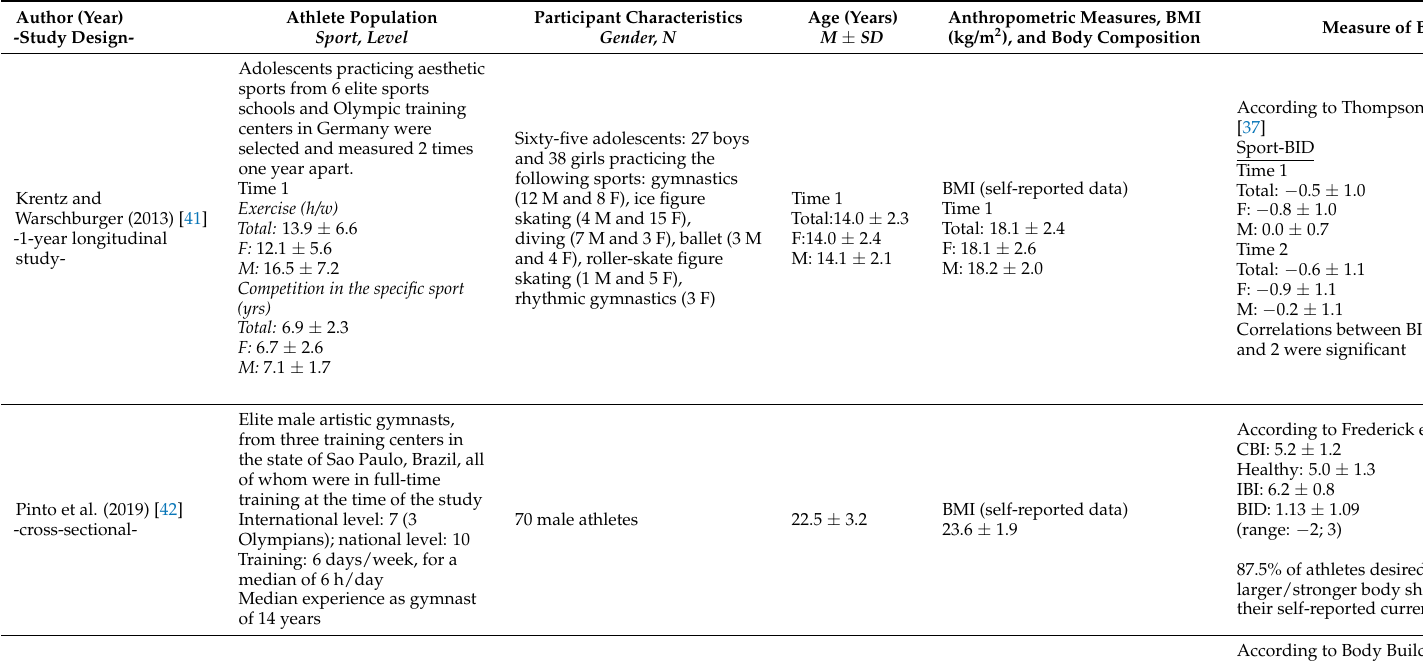
Significant correlations: -BMI-current body type Fat -BMI-self-reported %F -BMI-current body type